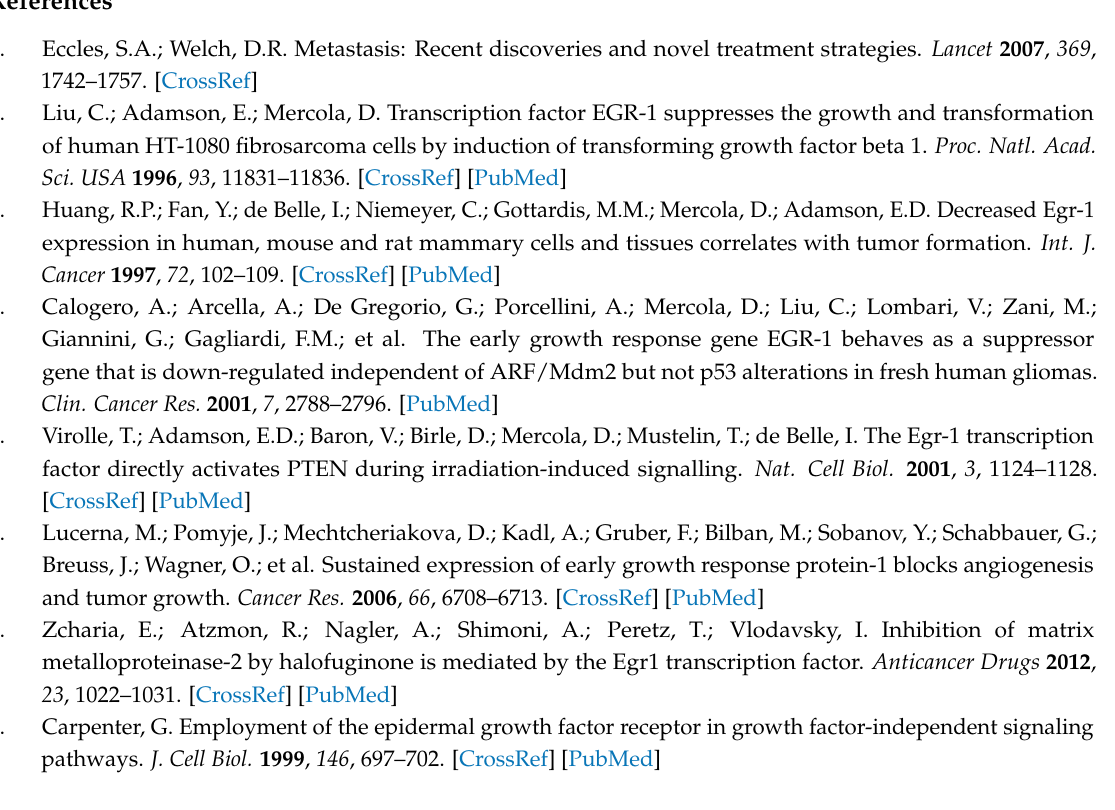
Figure S1: Heatmap representation of the relative mRNA expression levels of EGFR/EGR1 in the TCGA population of head and neck squamous cell carcinoma (HNSCC)